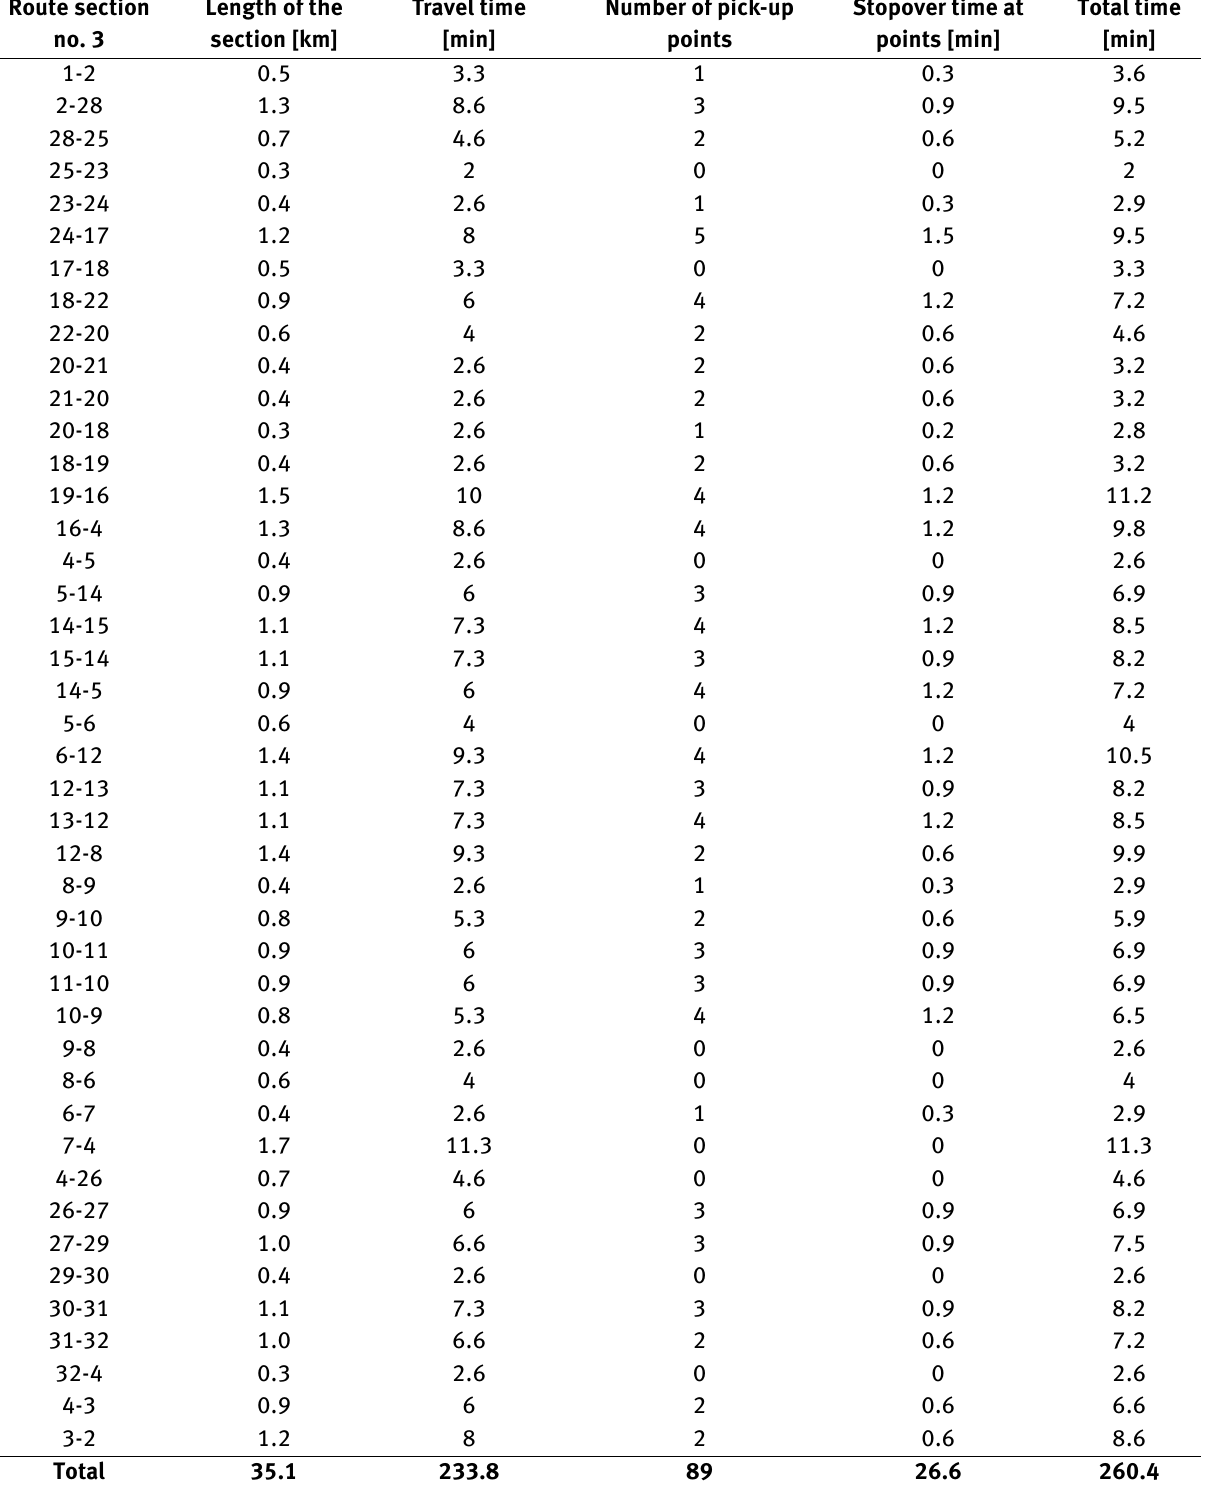
Table 6: List of the route followed by MZGK employees during the collection of segregated waste Route